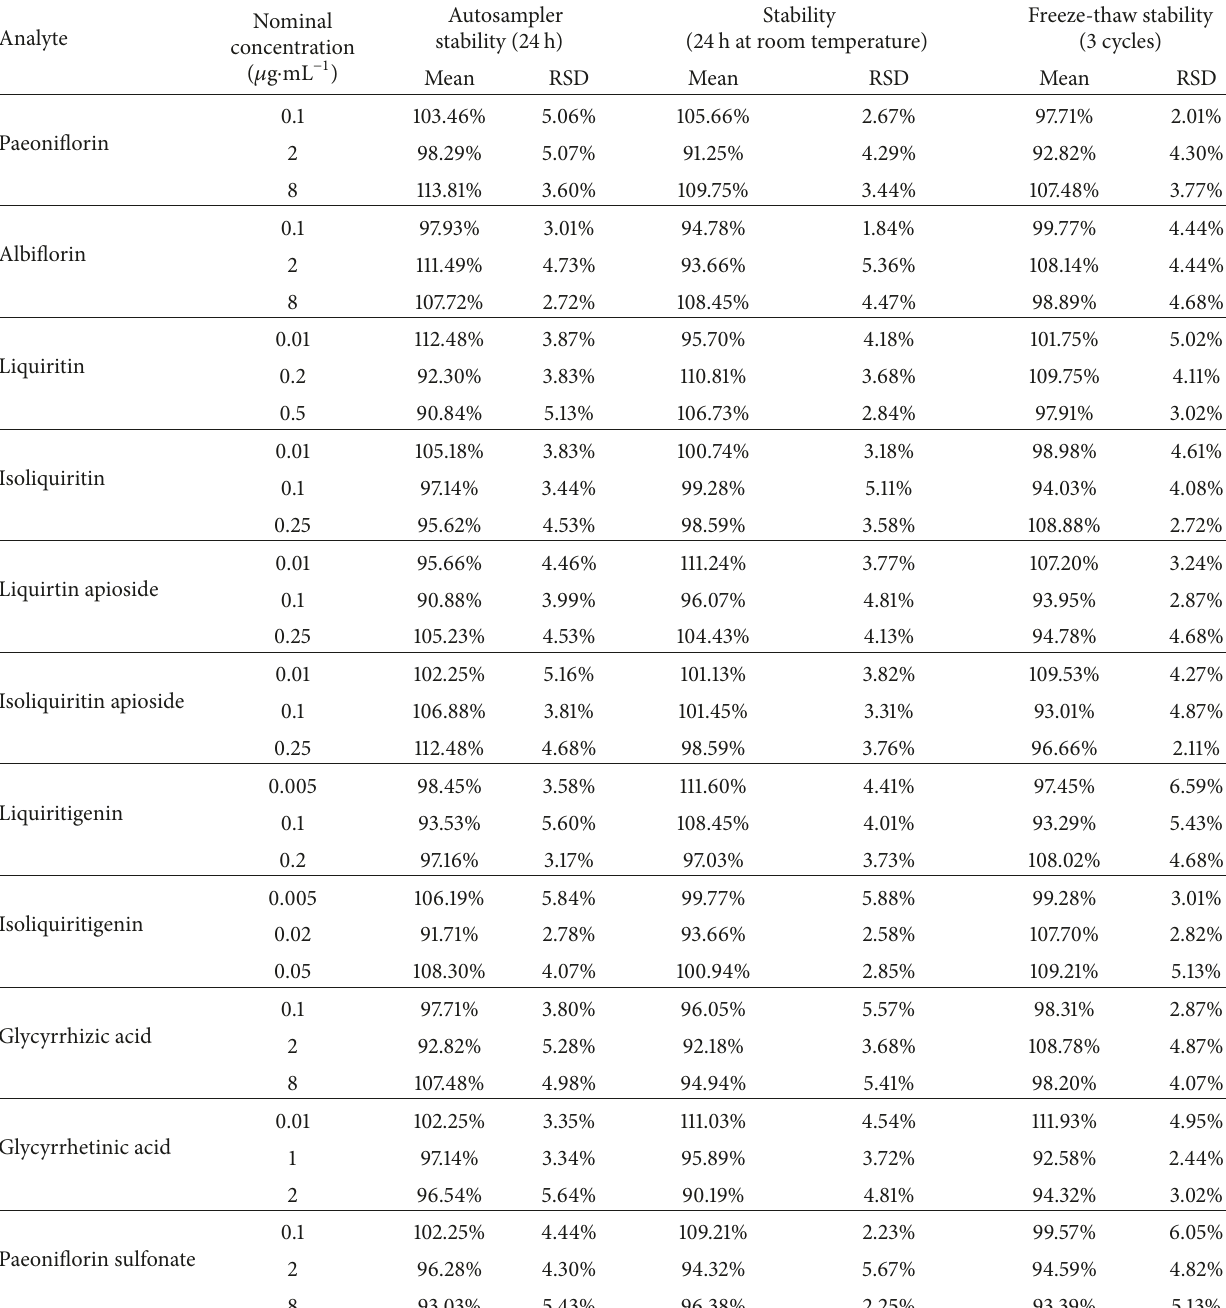
Table 5: The stability of detected compounds in rat plasma ( 𝑛 = 6